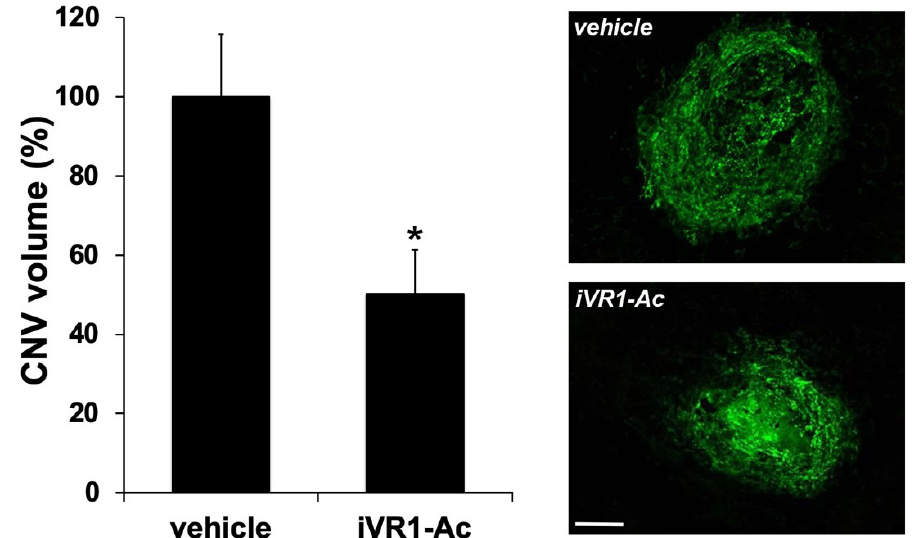
Figure 3. iVR1-Ac inhibited laser-induced CNV when delivered by gavage. After 7 days from laser-induced damage, CNV volumes were measured by Isolectin B4 staining of RPE-choroid flat mounts. N = 5 mice per group. The following number of spots were analyzed: vehicle = 10, iVR1-Ac = 20. Data are presented as the mean ± SEM. * p = 0.001 vs. vehicle. On the right, representative pictures of CNV are shown. Scale bar: 100 μm.